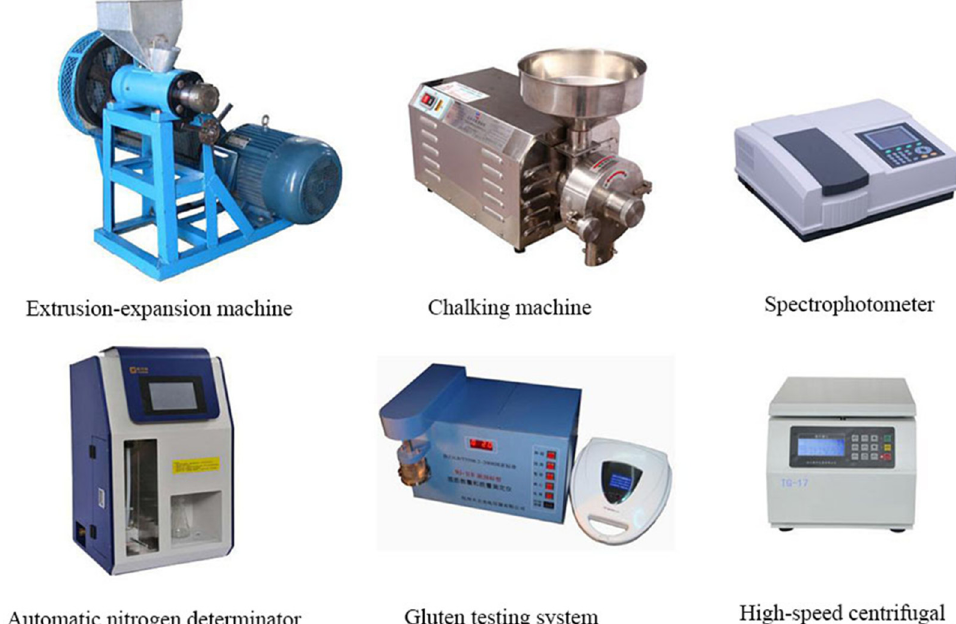
Fig. 1. The instruments for